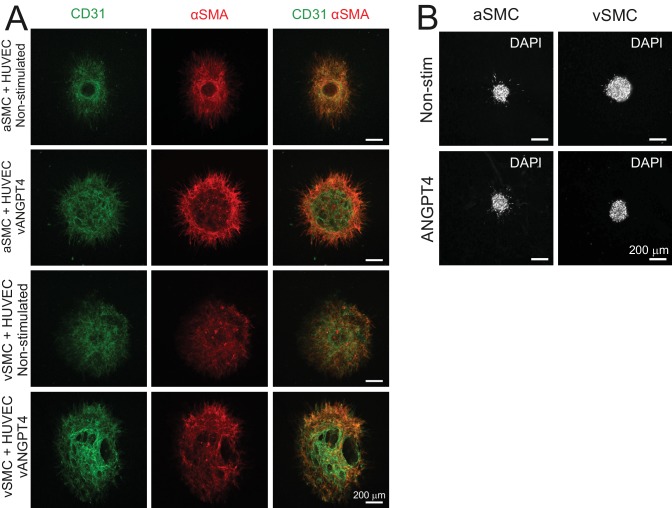
Smooth muscle cells do not enhance responsiveness to ANGPT4 in EC co-cultures nor respond directly to ANGPT4.(A) Co-culture spheroids of arterial (a) and venous (v) SMC and HUVECs or HUVECs virally (v) transduced with ANGPT4 were stained against CD31 and αSMA indicating ECs and SMCs, respectively. Presence of SMCs does not increase lumen formation of spheroids. (B) aSMC and vSMC spheroids alone do not form lumen structure in the presence of purified recombinant ANGPT4.